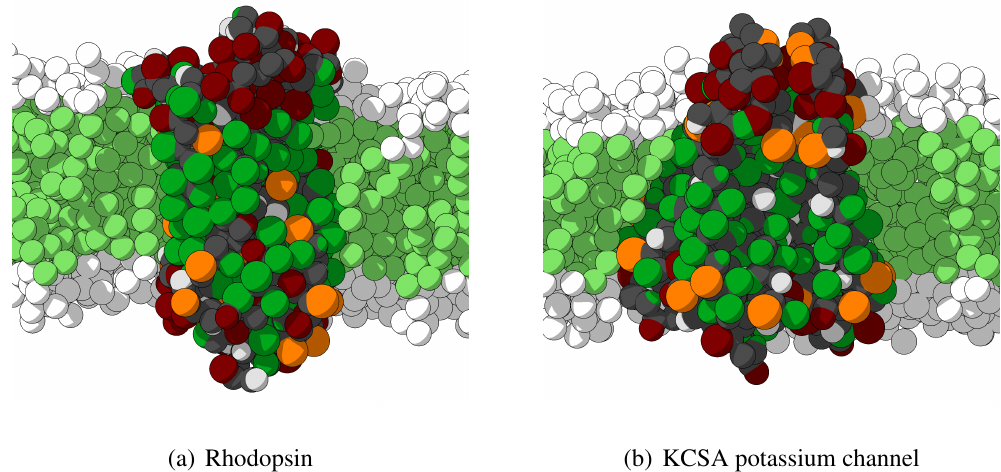
Figure 6. Initial configuration for the CG MD simulations for rhodopsin (on the left) and the KCSA potassium channel (on the right). Both proteins are embedded in an H4T4T4 lipid membrane, for both configurations only the part surrounding the proteins is shown and water and some lipids have been removed for clarity.